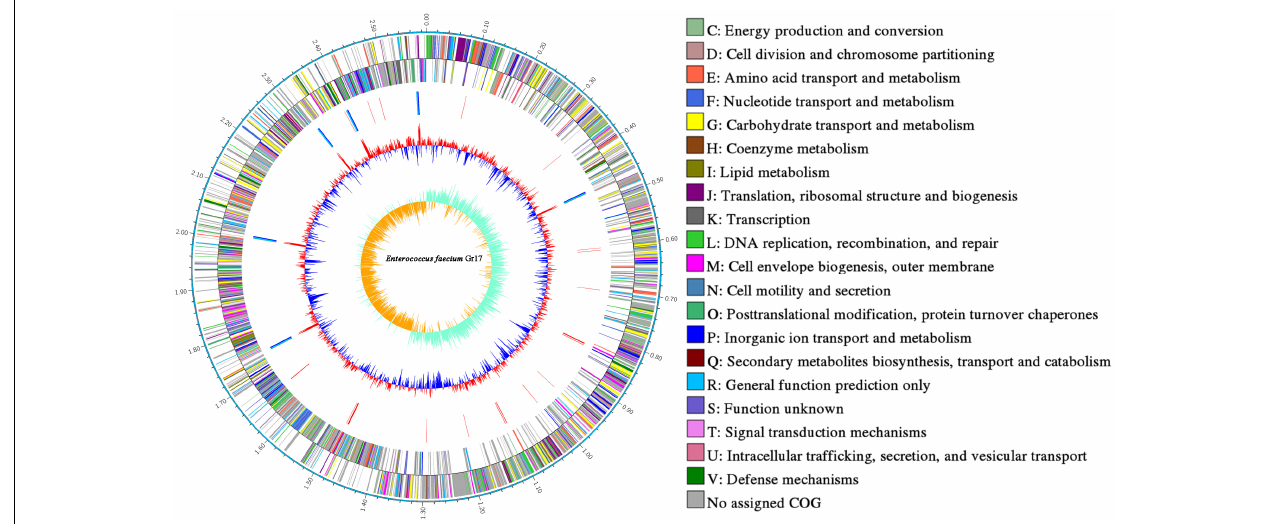
FIGURE 1 | Circular genome map of Enterococcus faecalis Gr17. Ring 1: genome sequences. Rings 2 and 3: COG annotated coding sequences. Ring 4: KEGG enzymes. Ring 5: RNA genes. Ring 6: GC content. Ring 7: GC skew. Very short features were enlarged to enhance visibility. Clustered genes, such as several rRNA genes, may appear as one line due to space limitations. The image was created by using Circos